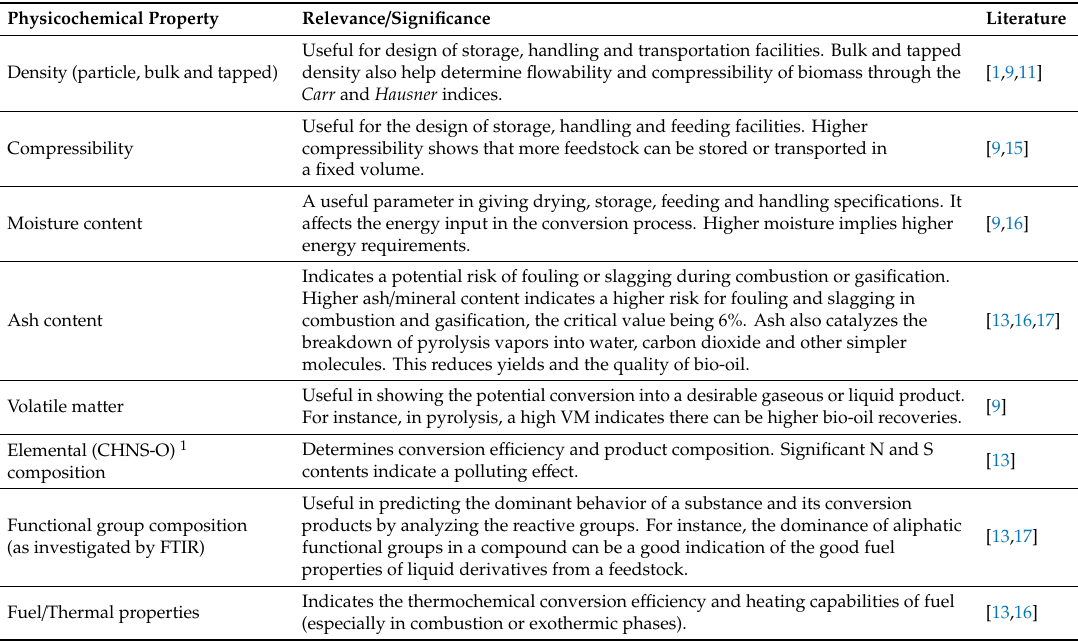
Table 1. Selected physicochemical properties and their relevance to various process flow